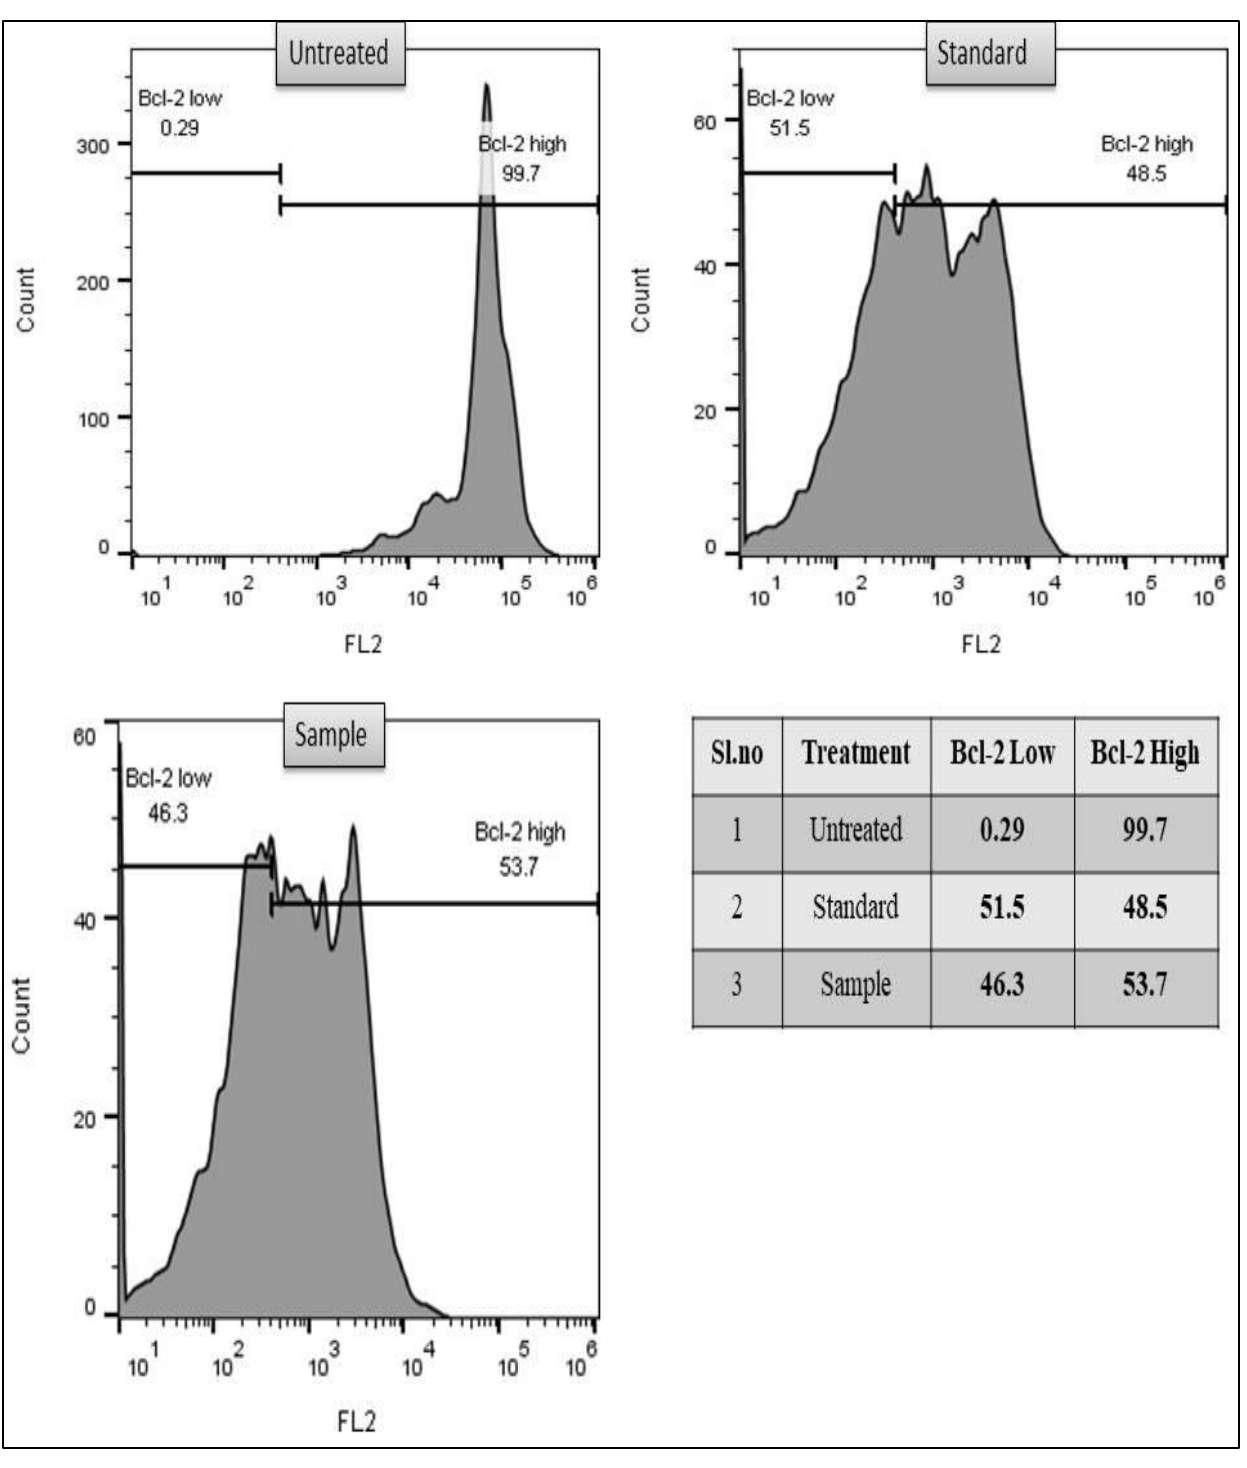
Figure 6. Flow cytometry-based study of inhibition of anti-apoptotic protein BCL-2 through methanol extract of C. colocynthis in the breast cancer MCF-7 cell line.